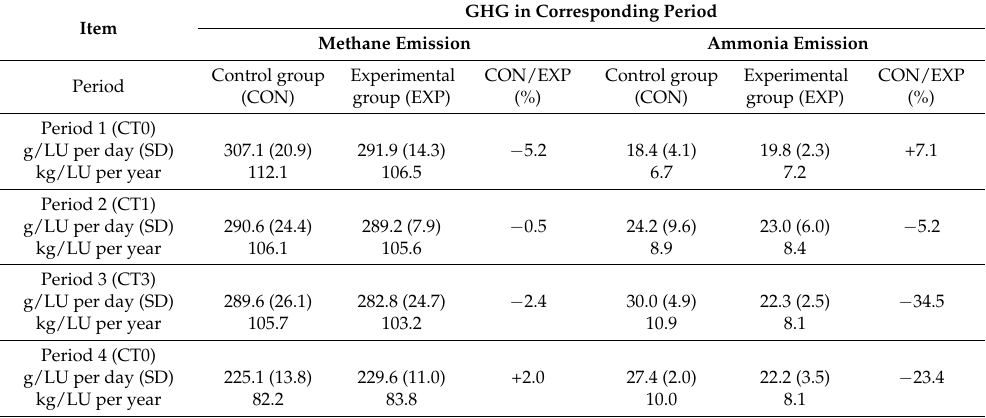
LU = livestock unit ˆ = 500 kg body weight; CT0 = all groups were fed without supplemented condensed tannins in the ration; CT1 = experimental group was fed with 1% condensed tannins in the ration; CT3 = experimental group was fed with 3% condensed tannins in the